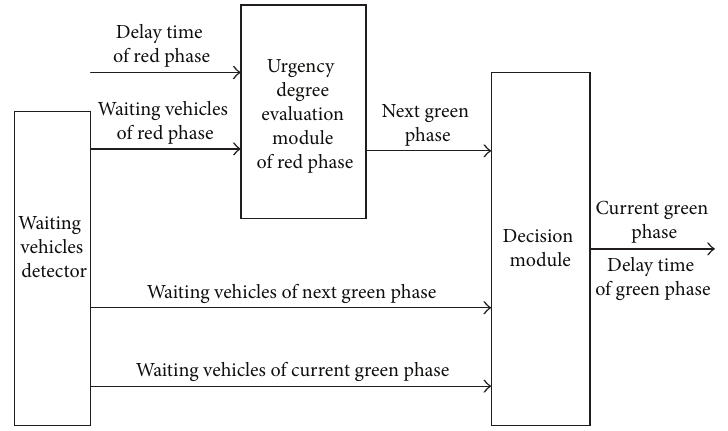
Figure 3: The chart of fuzzy control principle based on the urgency degree of red traffic